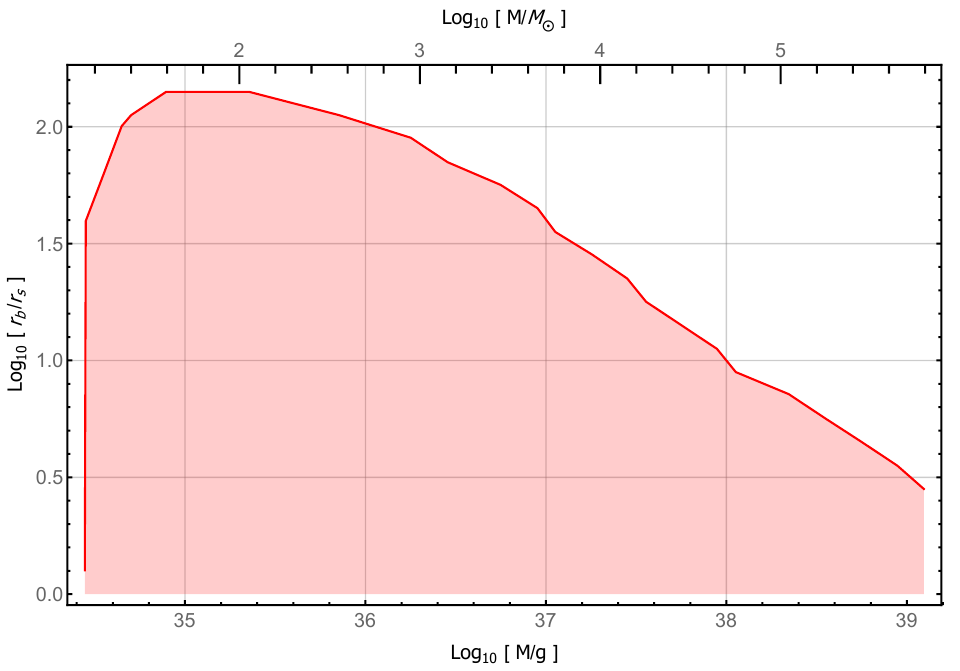
Figure 3 . Parameter space where the predicted blob merger contribution to the SGB lies above LISA’s expected sensitivity threshold [73] for f = 10 − 2 . The blob radius is presented in terms of the Schwarzschild radius, r s . The blob merger contribution to the SGB is too small for blobs lighter than 10 34 g to be visible to